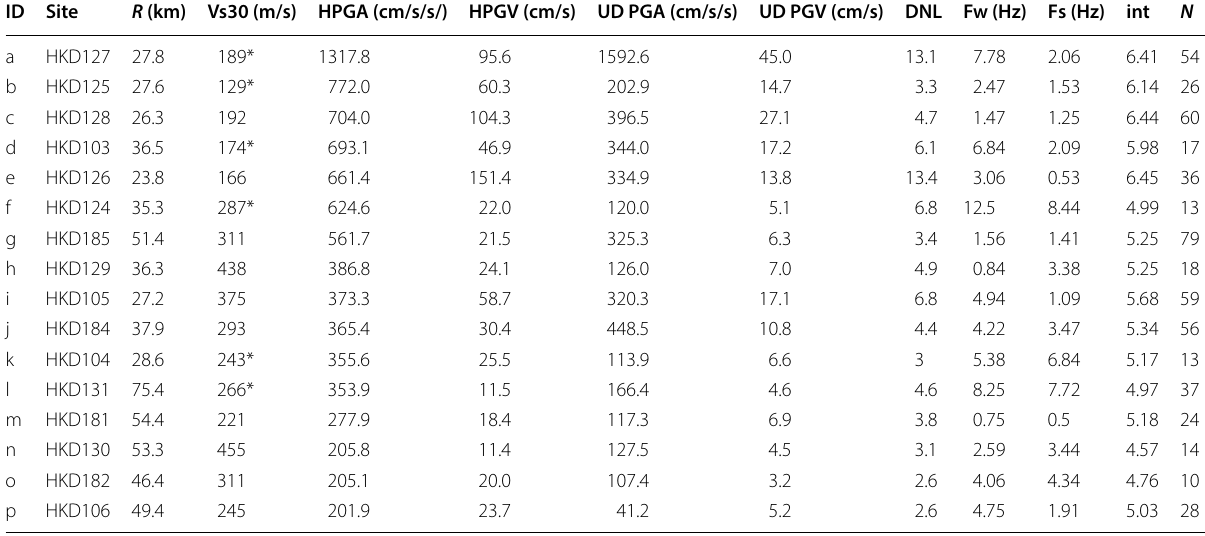
The first column with header ID marks the identification of each panel in Fig. 14. R, fault distance; the numerals marked with * under the header Vs30 are the values of Vs10 at the corresponding sites HPGA horizontal vector PGA; HPGV horizontal vector PGV; Fw and Fs predominant frequencies of strong- and weak-motions, respectively; N number of weak-motion recordings used; int JMA instrumental intensity calculated in this study. For other headers, see the text